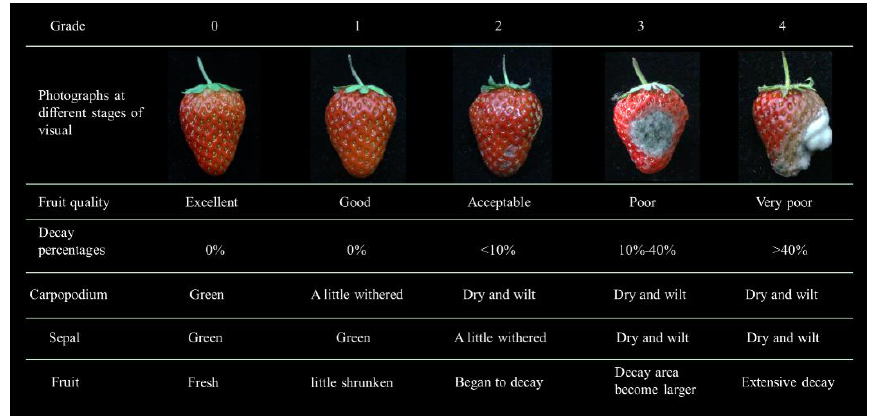
Figure 2. Incidence grade and descriptor for strawberry ( Fragaria × ananassa Duch.) fruit.